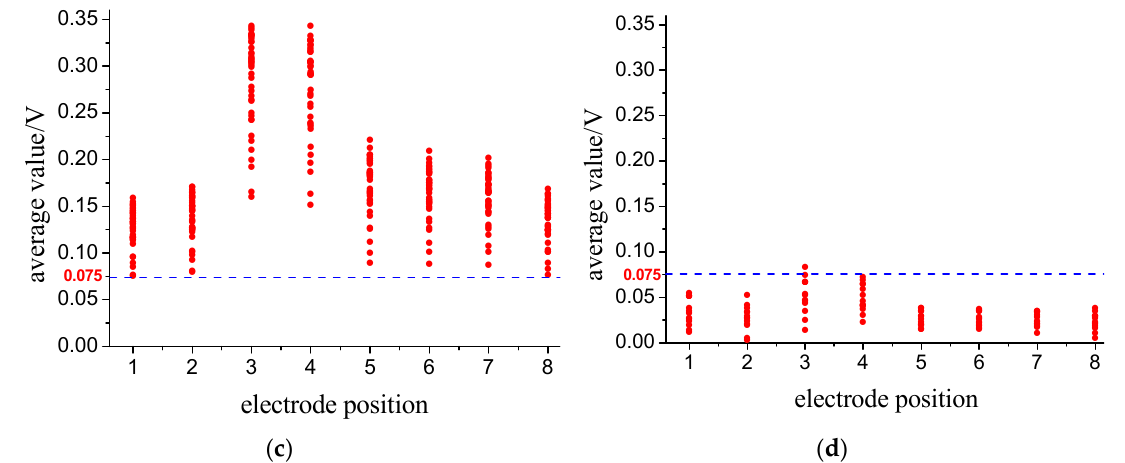
Figure 11. Regions of the four patterns using the average value. ( a ) fully suspended flow; ( b ) stratified flow; ( c ) dune flow; ( d ) slug flow.